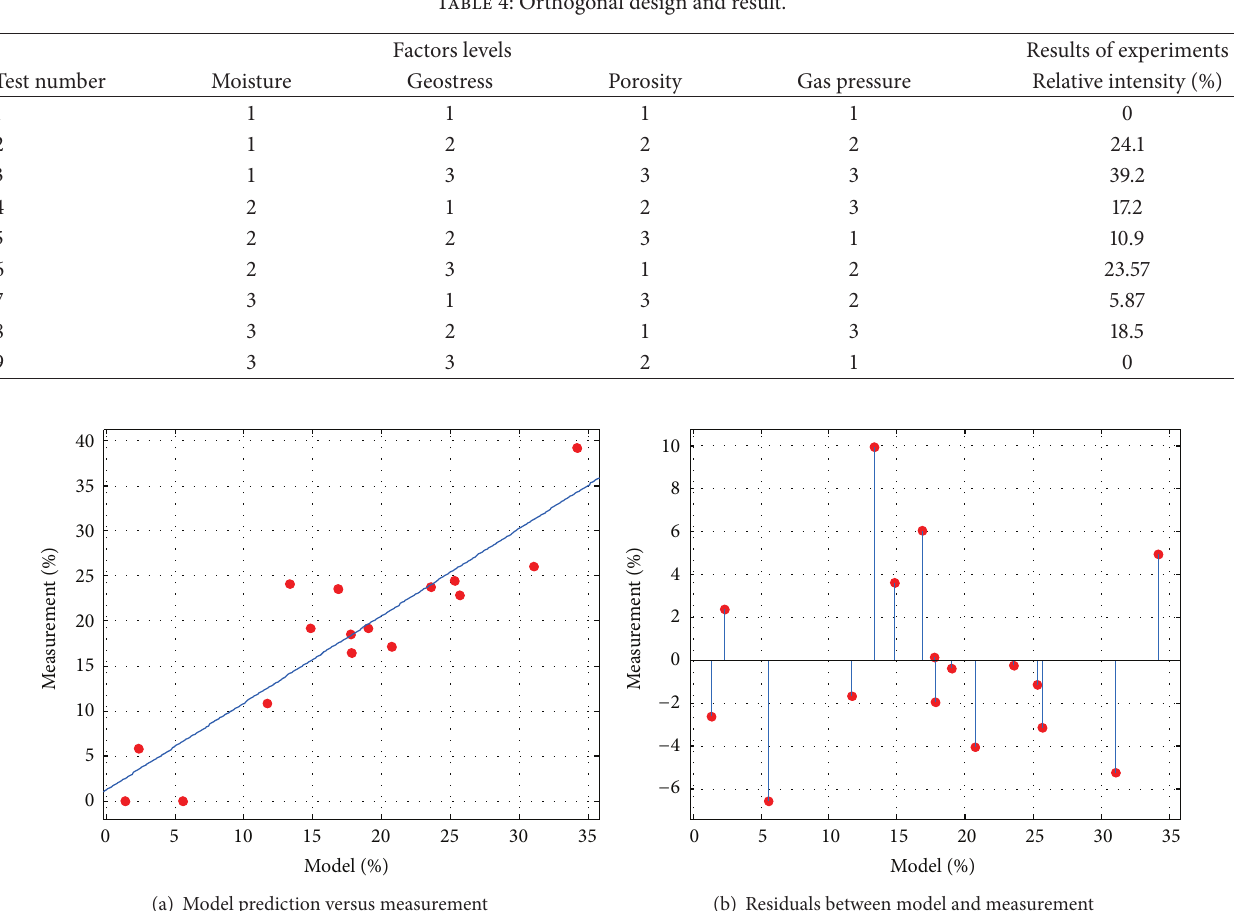
Table 4: Orthogonal design and result.